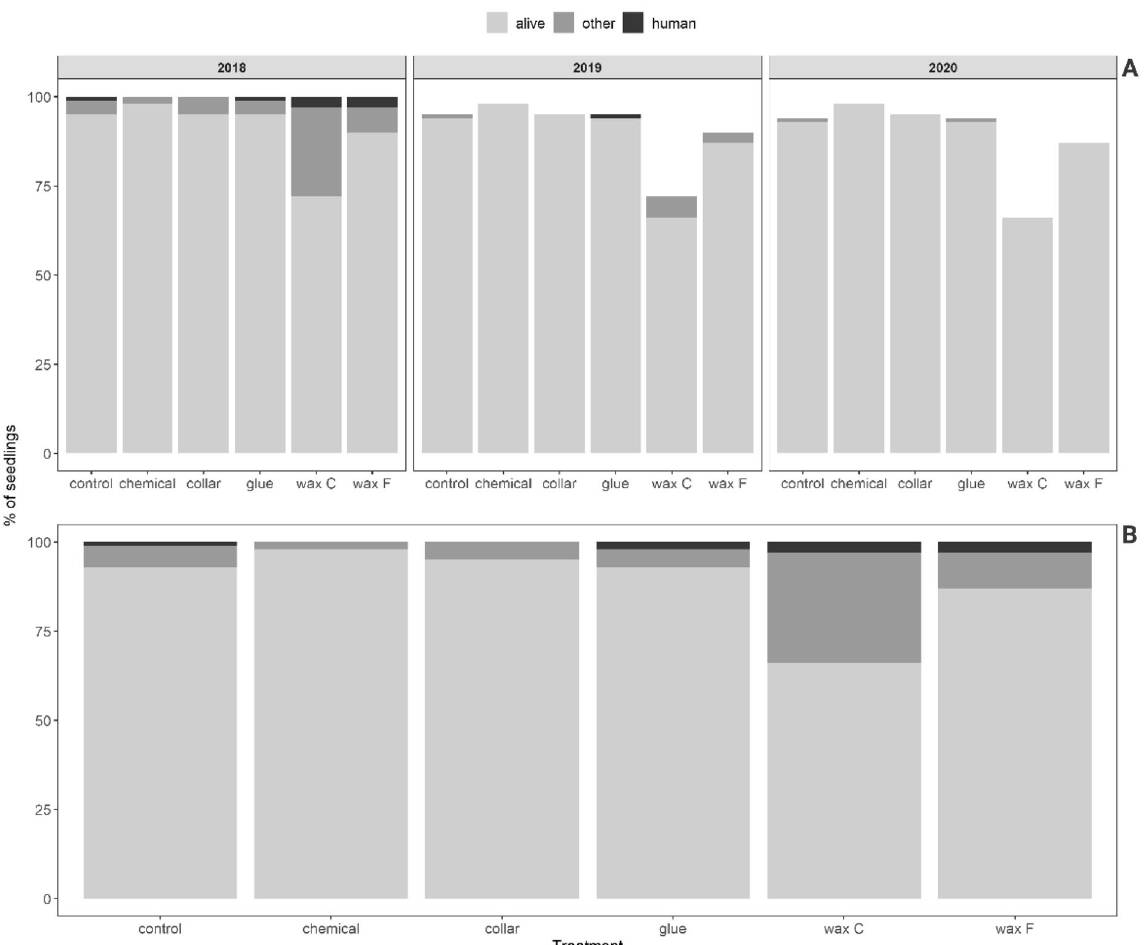
Figure 4. ( A ) Mortality of seedlings at the nursery site in each of 3 years of the experiment as affected by the treatments. ( B ) Total seedling mortality at the nursery site over the 3 years of the experiment as affected by the